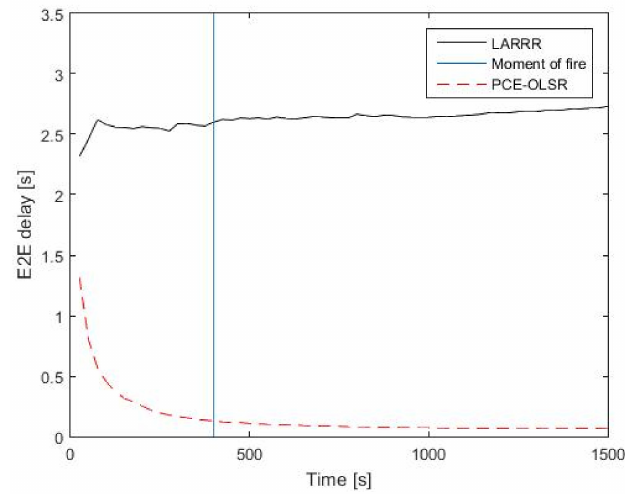
Figure 13. E2E delay results between LARRR and